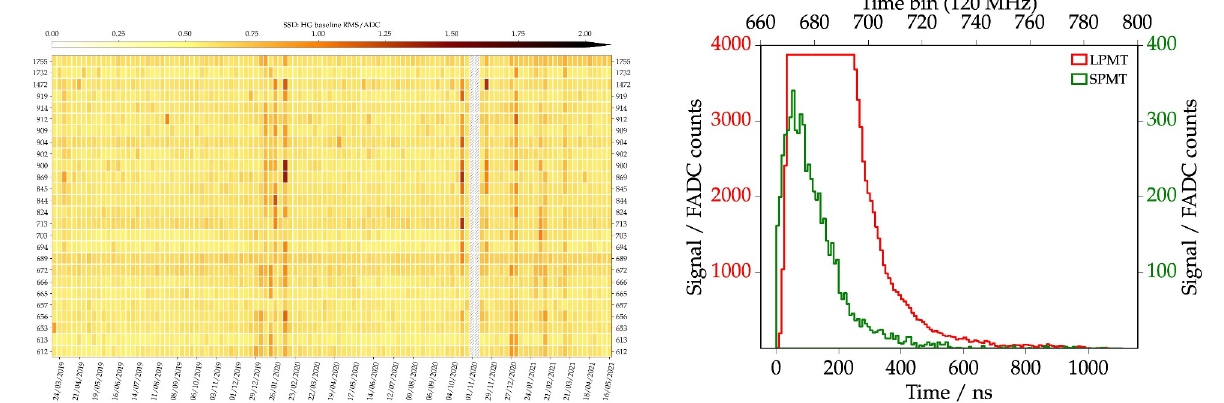
Figure 2. Left: evolution of the baseline of the PMTs high gain trace for a subsample of SSD of the preproduction array. Right: large PMT (LPMT) and small PMT (SPMT) signals in a detection station: the anode channel of the LPMT is clearly saturated (red), while the SPMT is providing an unsaturated signal